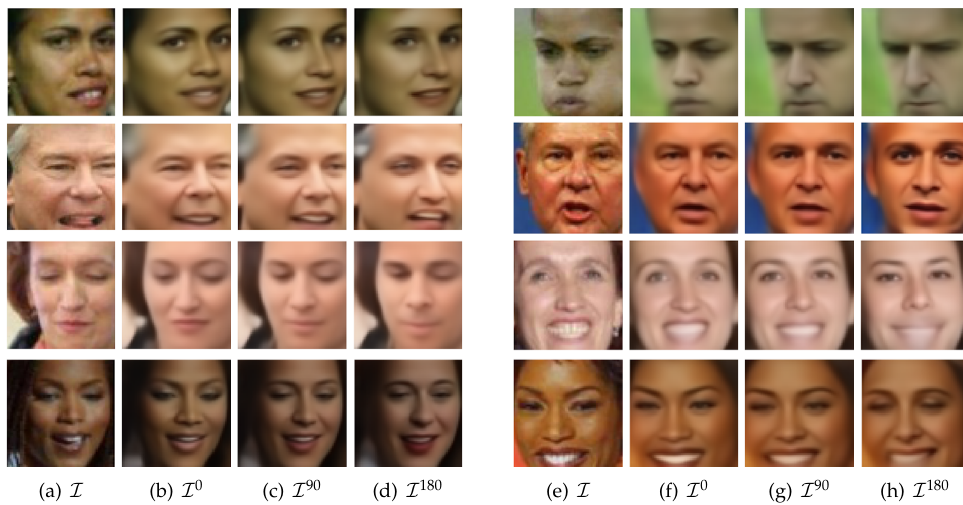
Figure 7. Results from the Labeled Faces in the Wild (LFW) dataset. ( a , e ) show original input images, ( b,f ) show reconstructed images (i.e. rotated with 0 degrees), ( c,g ) show de-identified faces by rotating 90 degrees, and ( d,h ) show de-identified faces by rotating 180 degrees.